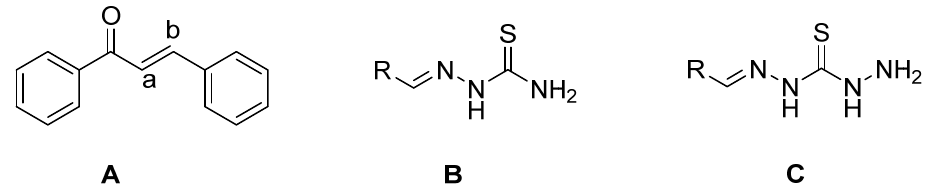
Figure 1. Structure of chalcone or (2 E )-1,3-diphenylprop-2-en-1-one ( A ), thiosemicarbazones ( B ), thiocarbohydrazones ( C ).